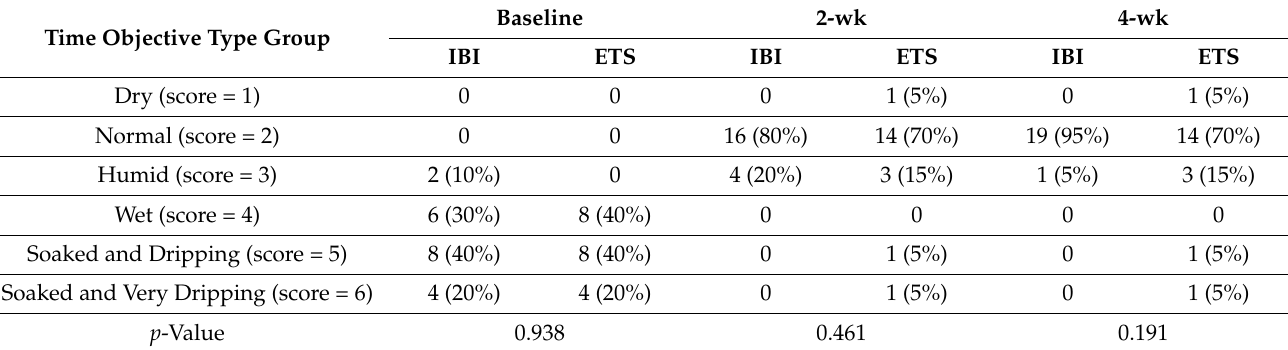
Table 4. Objective evaluation of patients up to the 4-week follow-up.